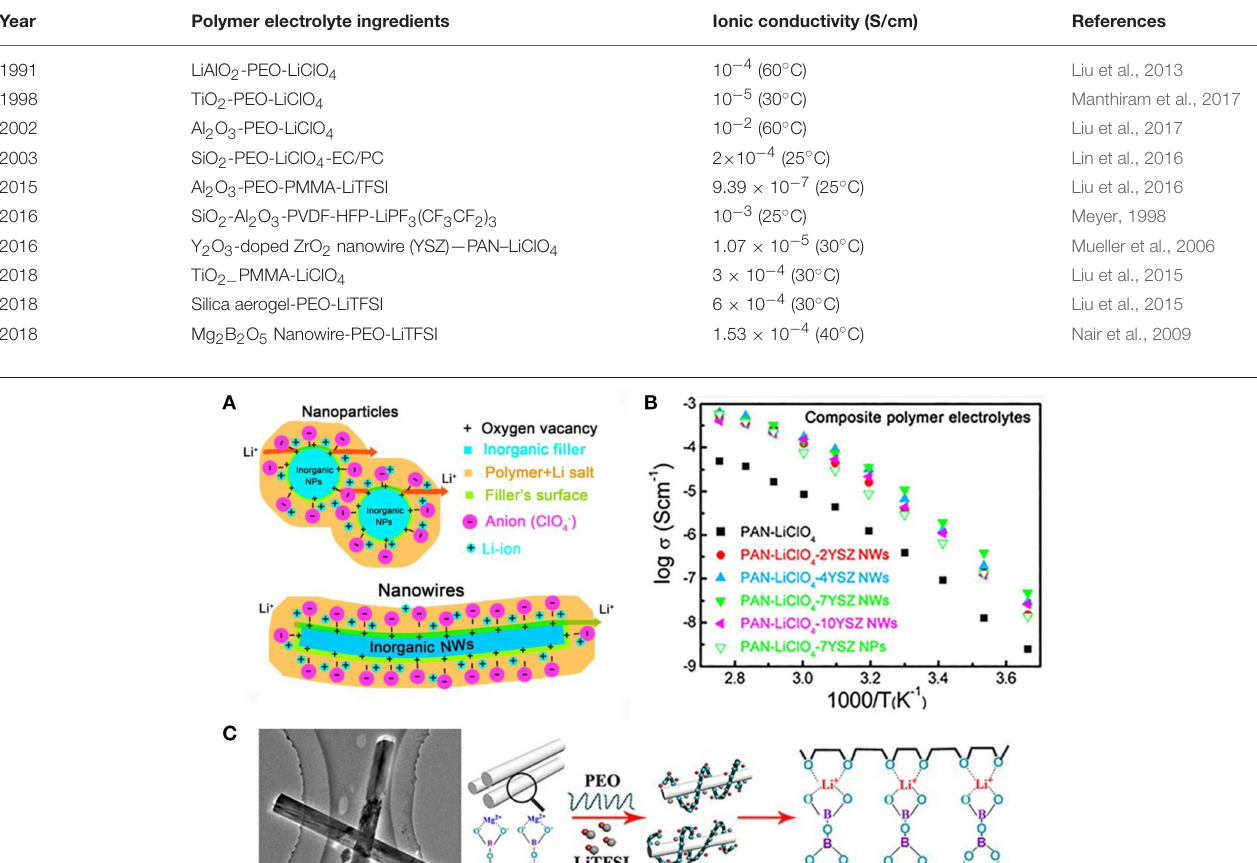
TABLE 2 | Summary of inert oxide Ceramics/polymer solid electrolytes. Year Polymer electrolyte ingredients Ionic conductivity